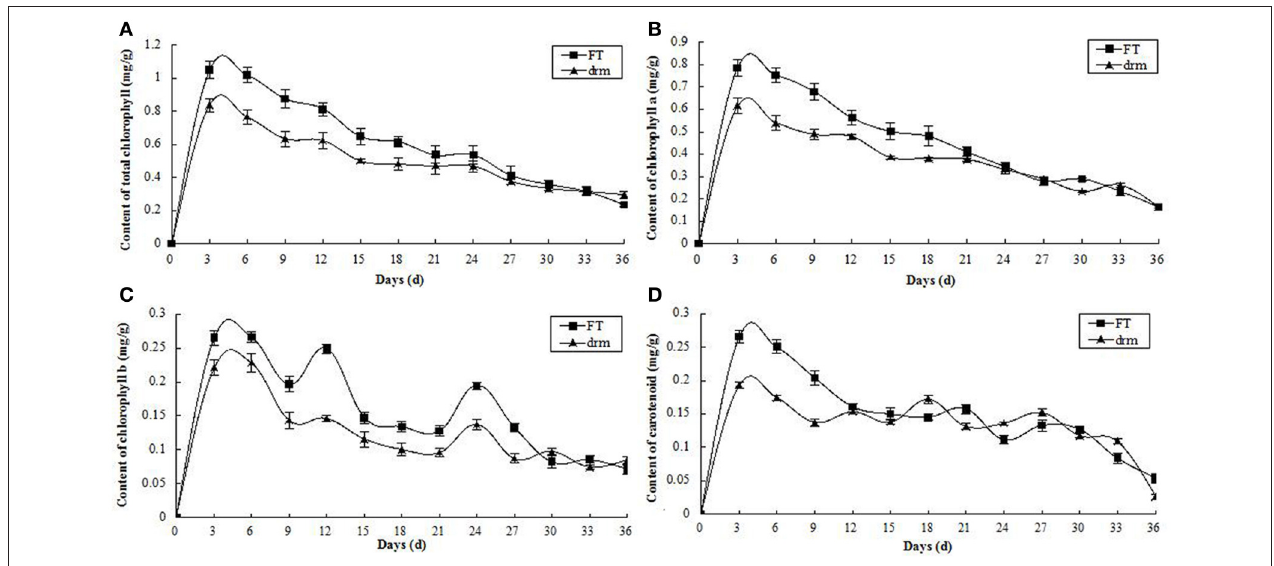
FIGURE 3 | Dynamic changes in chlorophyll and carotenoid contents in drm and wild-type “FT” at the seedling stage. (A) total chlorophyll contents; (B) chlorophyll a contents; (C) chlorophyll b contents; (D) carotenoid contents. Days (d): days after the third true leaves appeared. Each value is the mean of three independent experiments. The error bars represent standard error (SE) of the